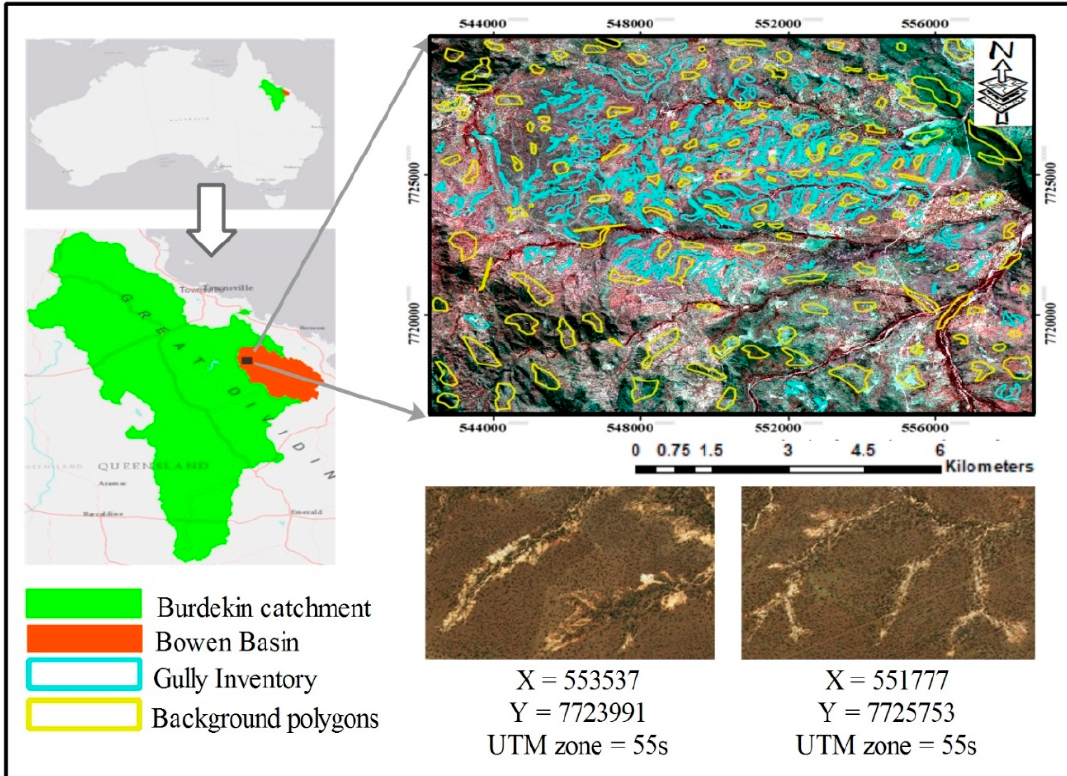
Figure 1. Location of study site in the Bowen Catchment. The background images are Sentinel 2A 10-m resolution false color composite and from Google Earth.